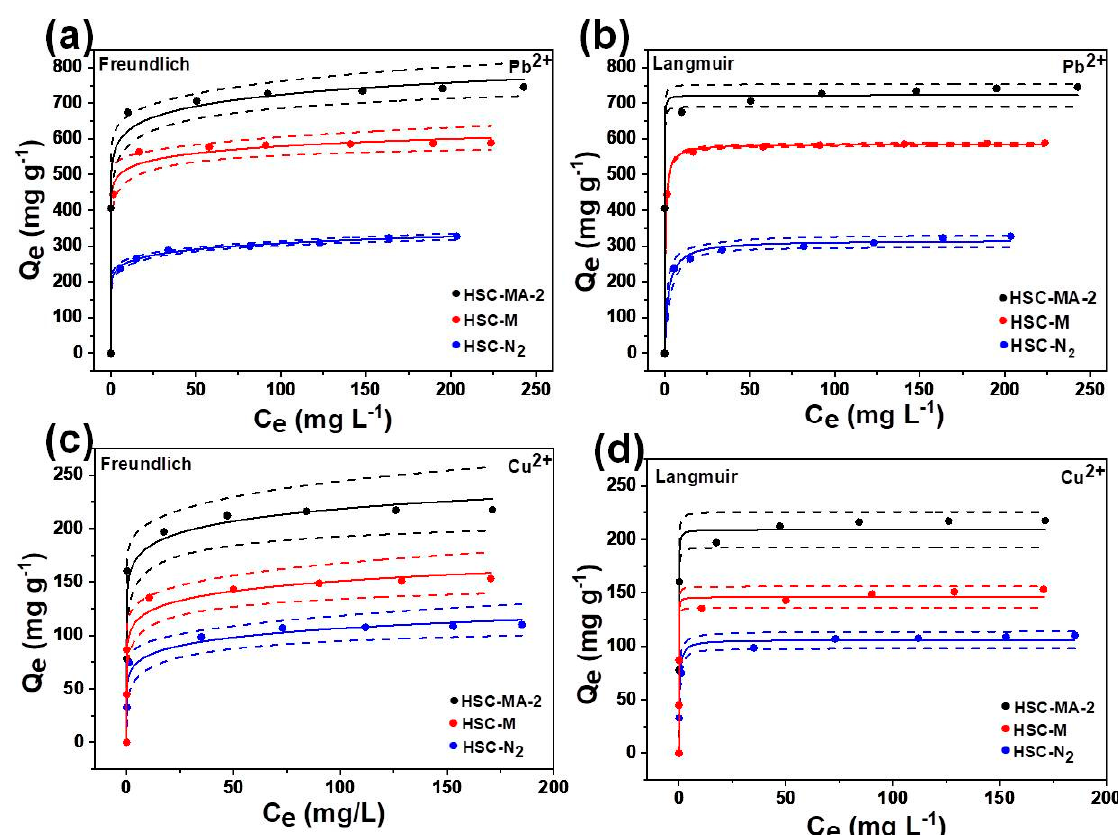
Figure 8. Freundlich sorption isotherms of ( a ) Pb 2+ and ( c ) Cu 2+ ; and Langmuir sorption isotherms of ( b ) Pb 2+ and ( d ) Cu 2+ on the HSC-N 2 , HSC-M and HSC-MA-2.